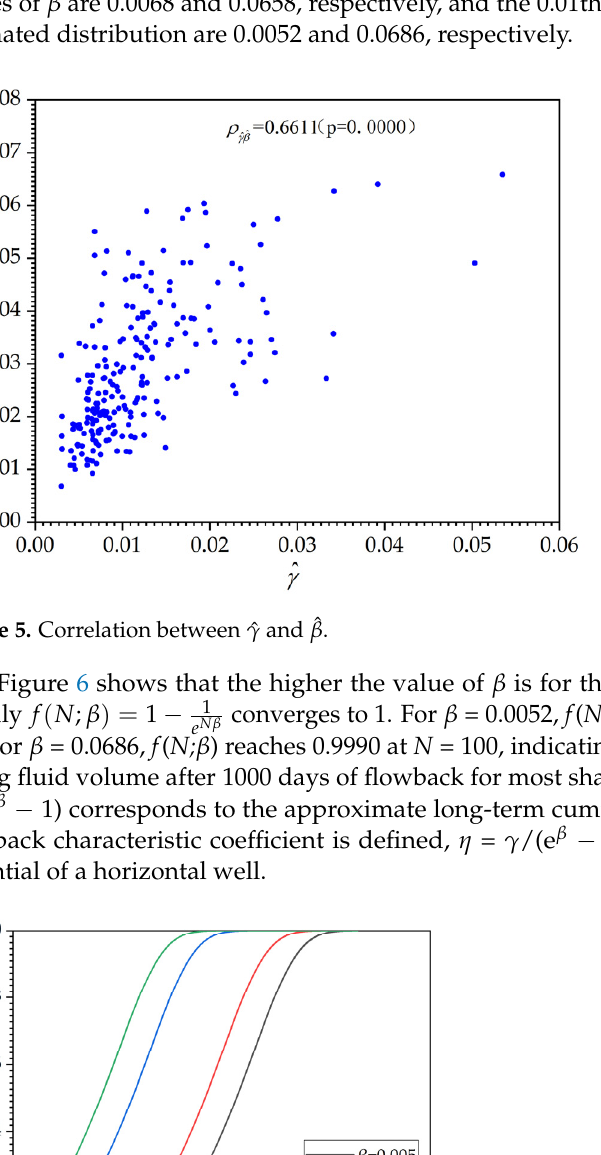
10 of 16 Figure 4. Best estimated distribution of 𝛾 (cid:3549) and 𝛽(cid:4632) . The Kolmogorov–Smirnov test was conducted on the empirical distributions of 𝛾 (cid:3549) and 𝛽(cid:4632) , and the optimal distributions had p values of 0.8209 and 0.4793, respectively, which were both above 0.05. Therefore, the distributions in Figure 3 can be used as em- pirical distributions of 𝛾 (cid:3549) and 𝛽(cid:4632) . As can be seen from Figure 3, the fitting results of 214 wells are statistically significant and can be further used for big data analysis. For the Weiyuan shale gas block, this empirical distribution can be used to predict the most likely